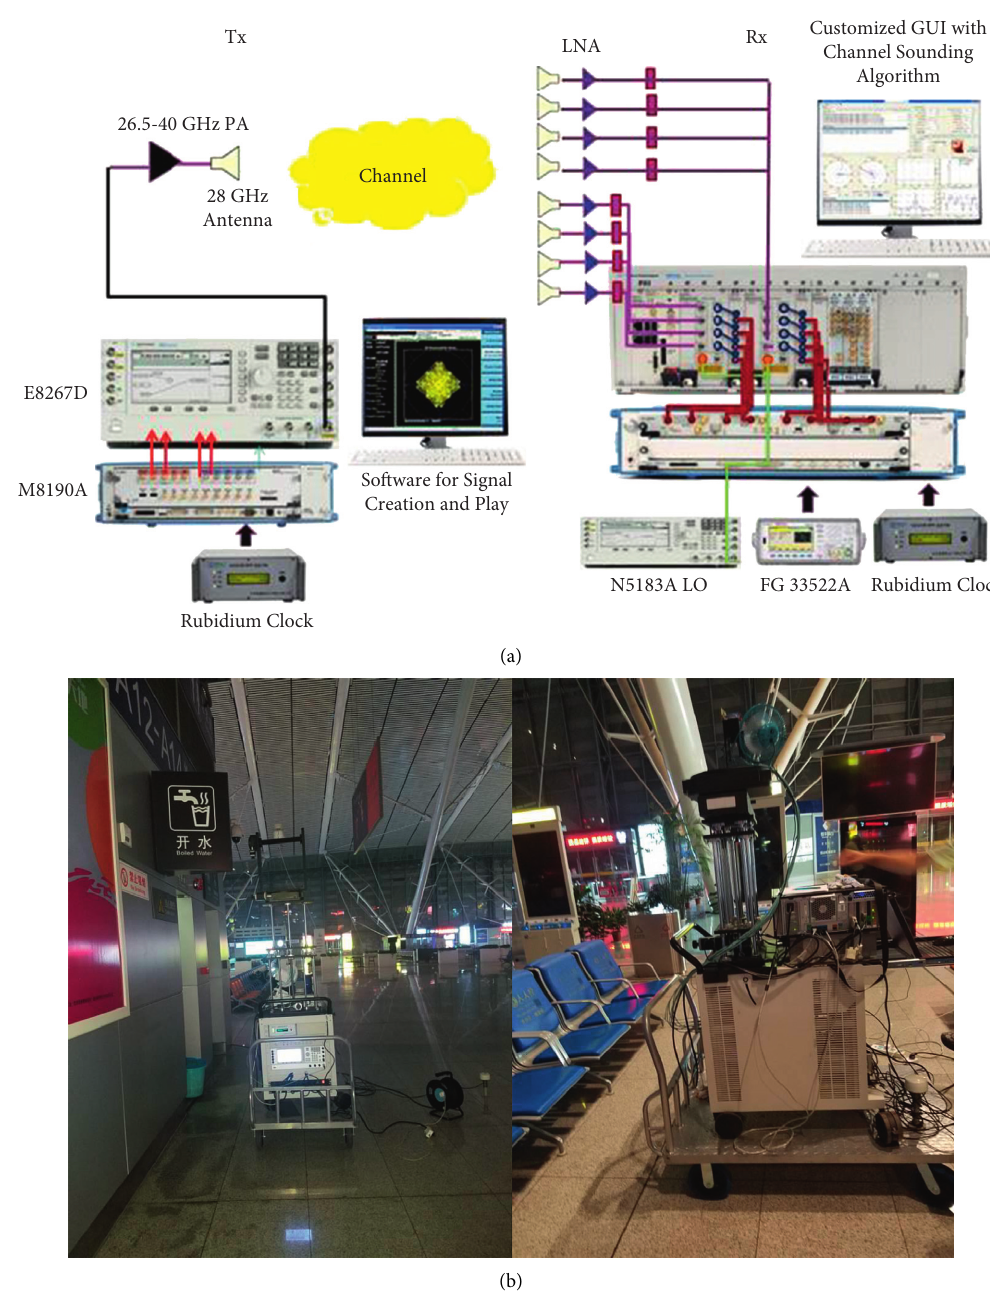
Figure 2: Measurement setup. (a) Photograph of the Tx and Rx apparatuses for the channel sounder, (b) measurement